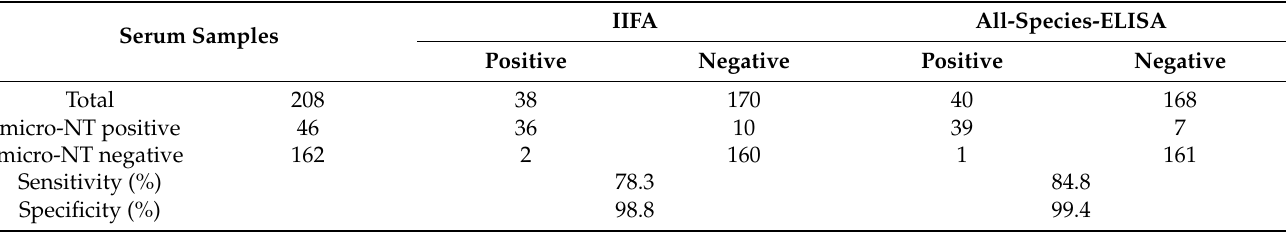
Table 1. Comparison of sensitivity and specificity of indirect immunofluorescence assays (IIFA) and ELISA. A total of 78.3% (36/46) of all micro-neutralization test (NT)-positive sera were confirmed by IIFA, while ELISA correctly identified 84.8% (39/46) as positive. Among the NT-negative samples, IIFA and ELISA correctly identified 98.8 (160/162) and 99.4% (161/162) as negative, respectively. Both the IIFA and ELISA results had a statistically significant correlation with the NT result ( p < 0.0001 Fisher’s exact